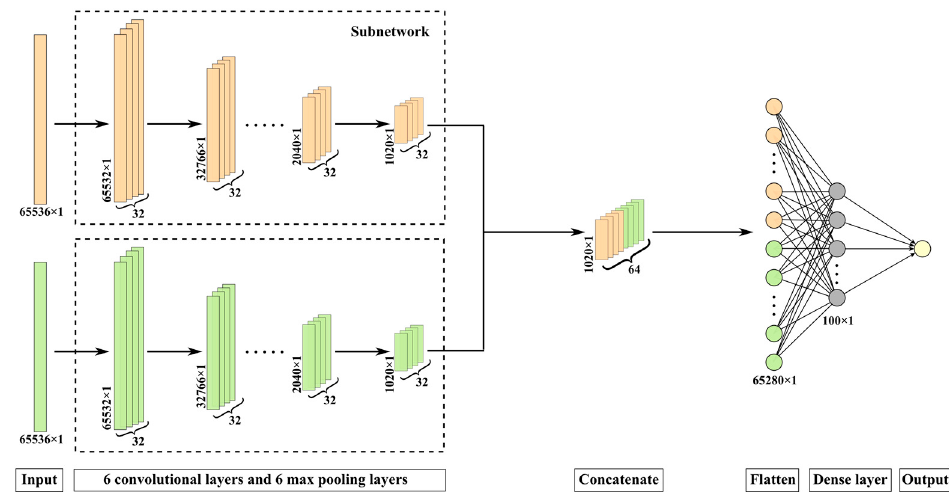
Figure 2. The detailed neural network architecture of pSCNN.